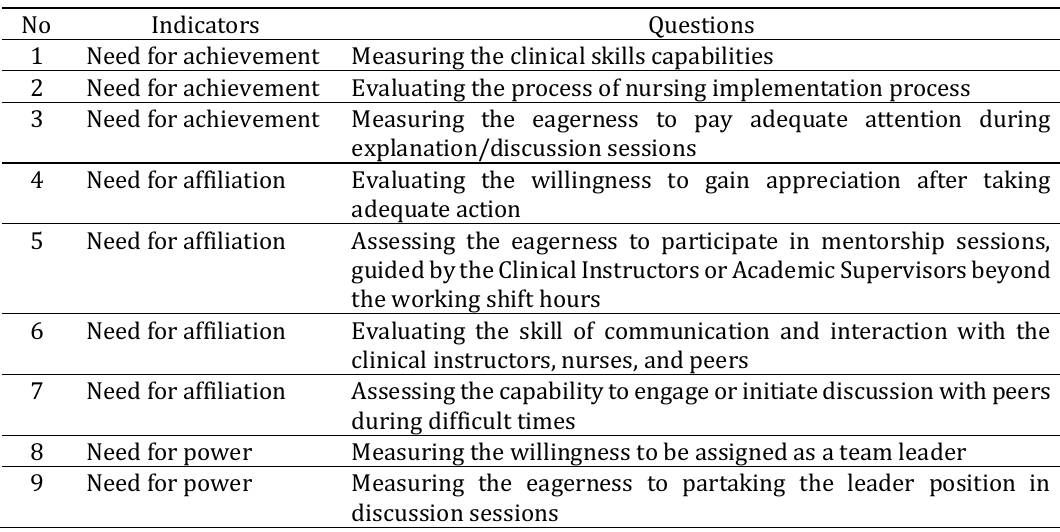
The Motivational Questionnaire Indicators